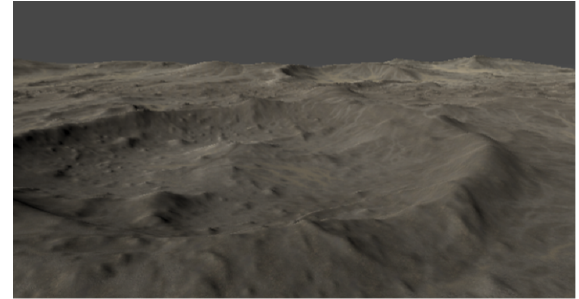
Figure 4. Simulation model of the lunar environment.